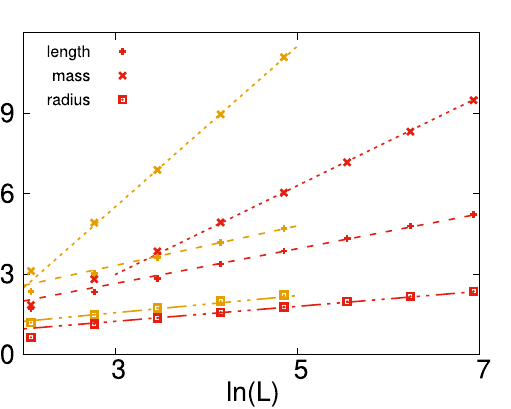
Figure 5. Average parameters of energy clusters in the d = 1 random TIM at �θ = θ = ln 2 as a function of the logarithm of the size of the system. From top to bottom: the minus log-gap −[ ln (ε) ] av , the length [ ℓ ] av , the mass [ µ ] av and the radius of gyration [ R g ] av . The slopes of the straight lines are 1.74, 1.7, 1.0 and 0.75, from top to bottom.